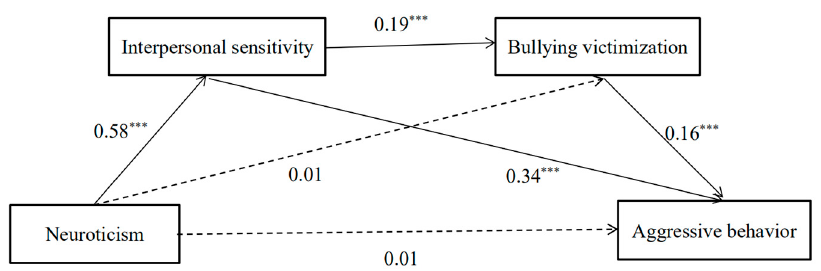
Figure 3. Results of mediation analysis for aggressive behavior among non-left-behind children. Standardized coefficients are presented. Note. *** p < 0.001. n = 453.